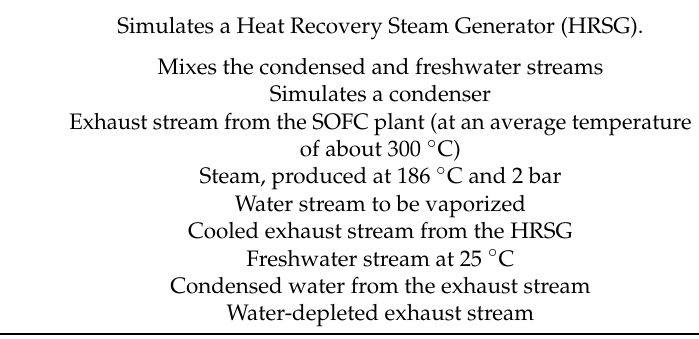
Figure 3. Steam generator system flowsheet.